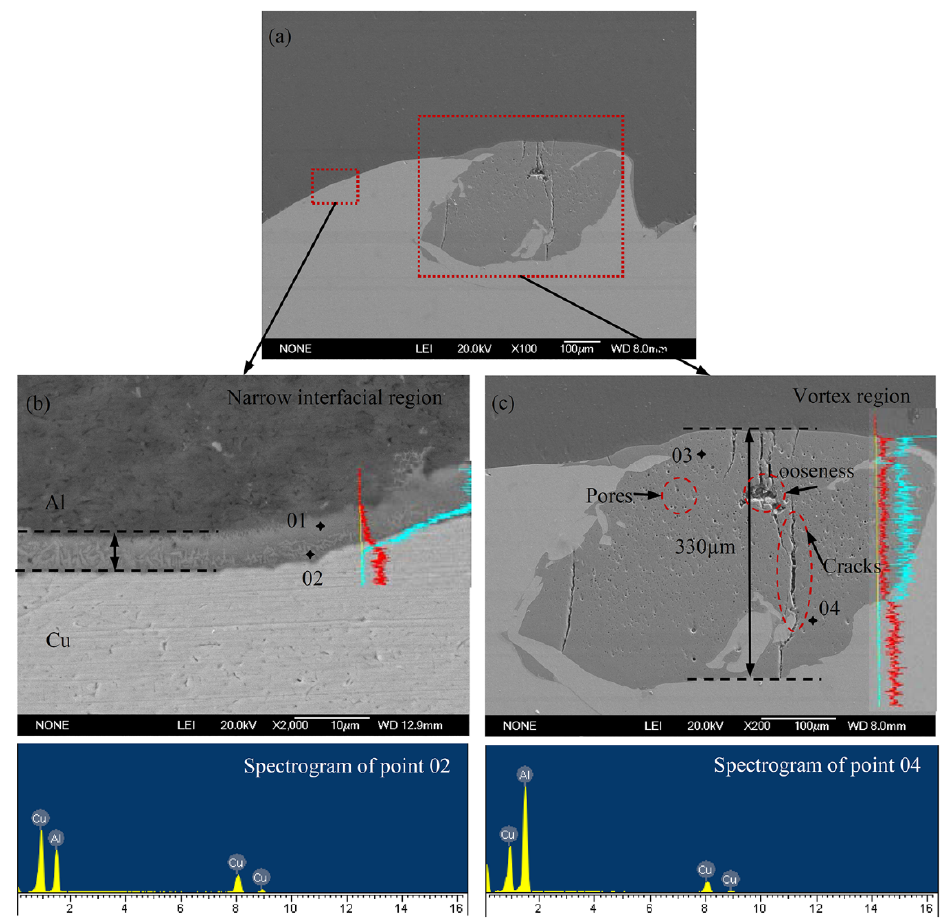
Figure 2. The typical interface morphology of Cu/Al cathode conductive head produced by explosive welding, shown as: ( a ) the interface microstructure, ( b ) the narrow interfacial region, and ( c ) the vortex